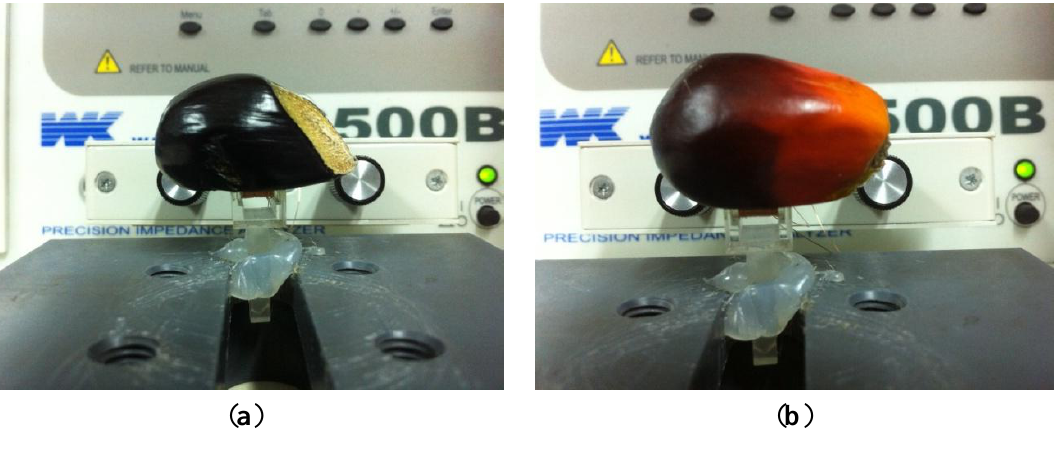
Figure 5. Measurement set-up of the resonant frequency of fruit samples ( a ) unripe ( b )